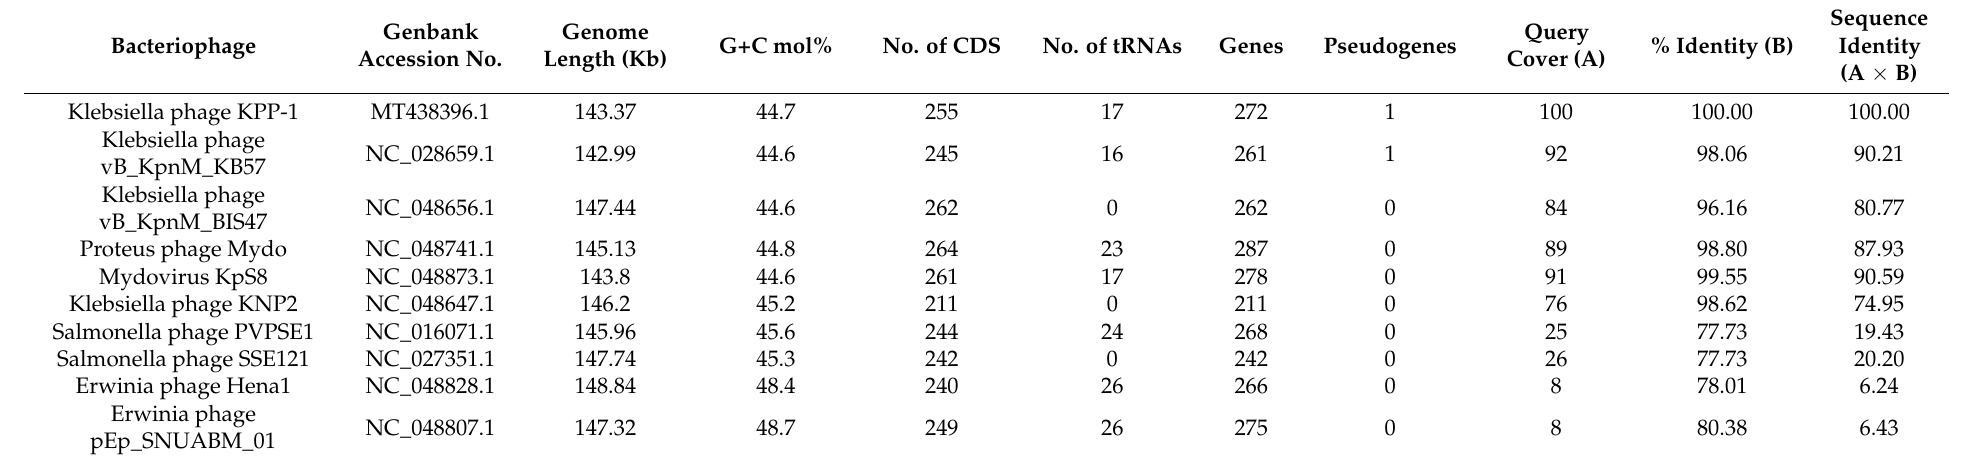
Table 1. Genomic and proteomic features of ICTV-classified Vequintavirinae phages and